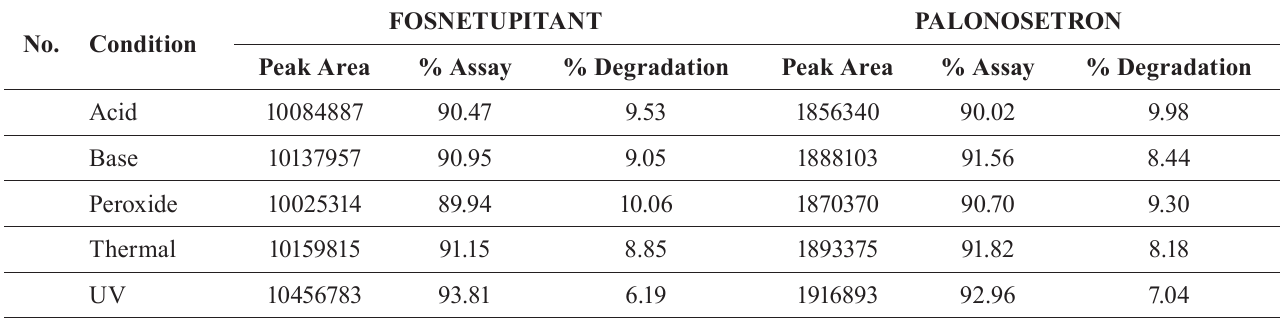
TABLE VIII - Forced degradation study